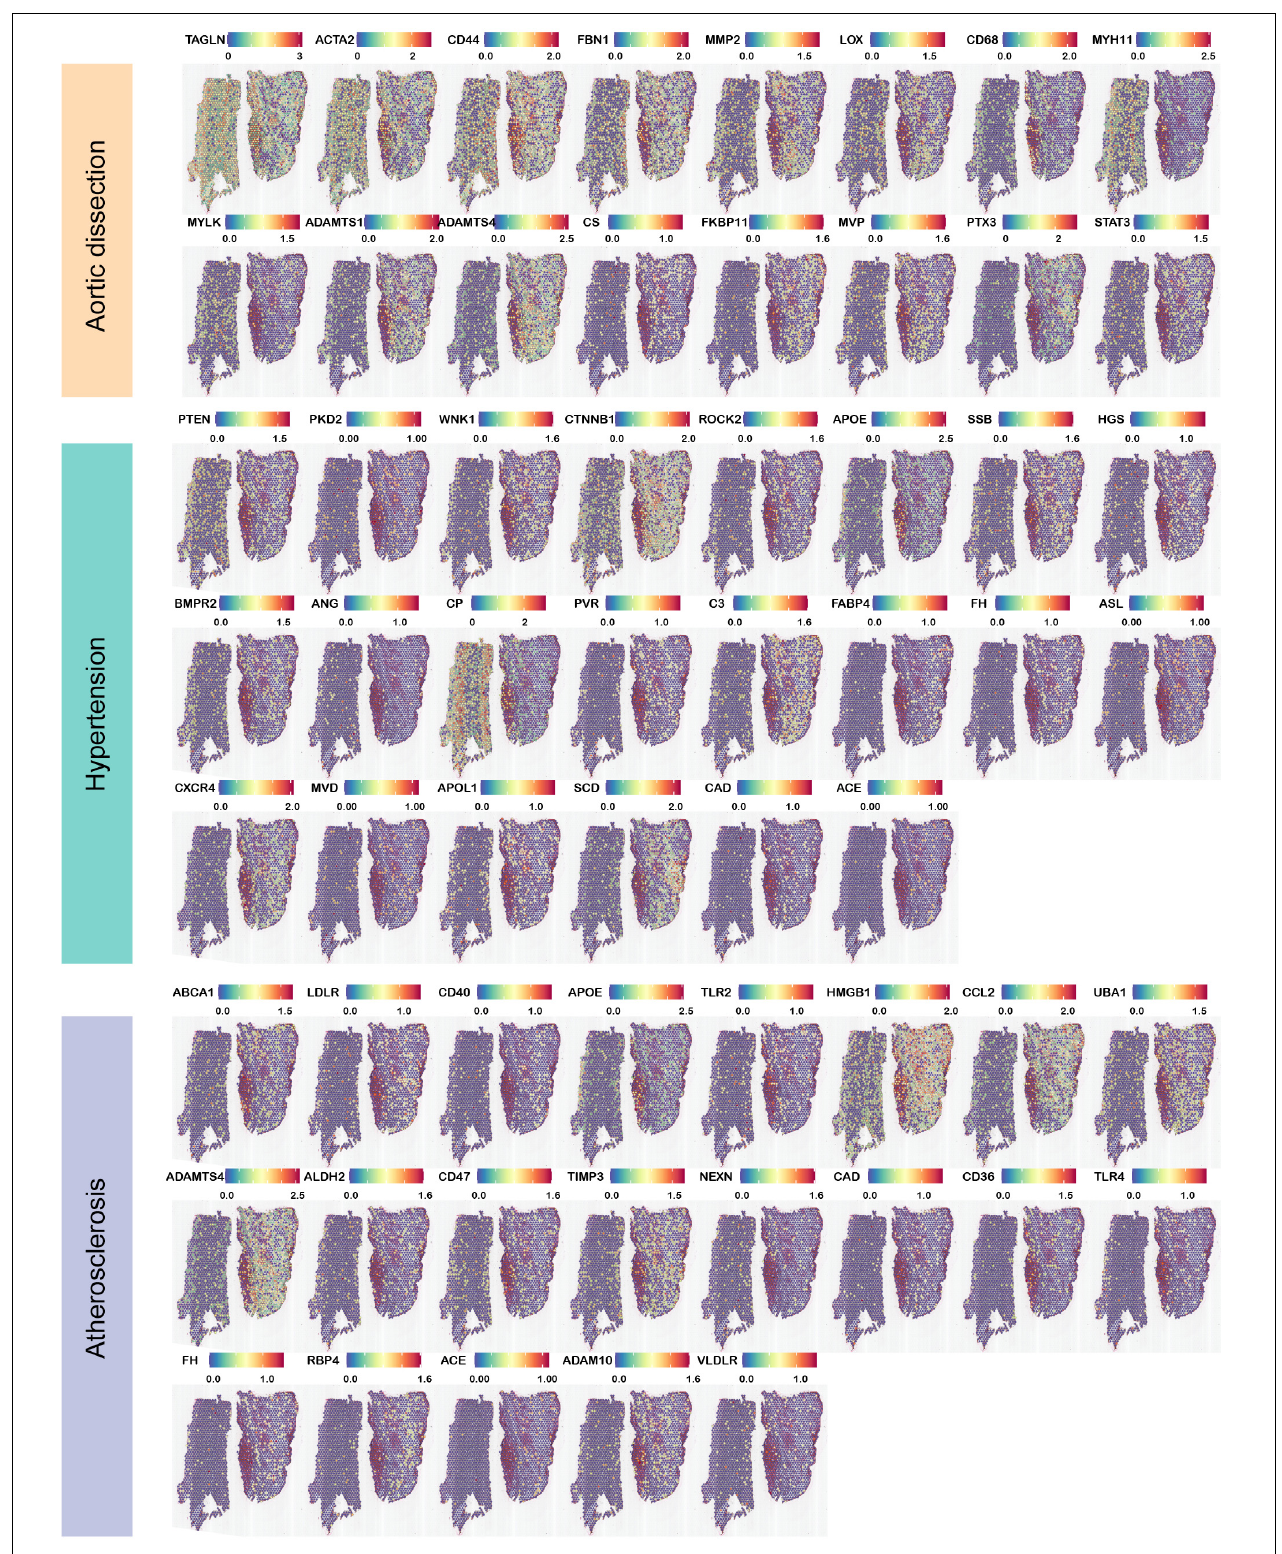
FIGURE 6 | Expression of highly expressed genes in dissection-related pathogenic factors in aortic dissection. Aortic dissection has reported the expression of highly expressed genes (hypertension, atherosclerosis) in dissection tissues of pathogenic factors. ST profiles of hypertension and atherosclerosis are listed.